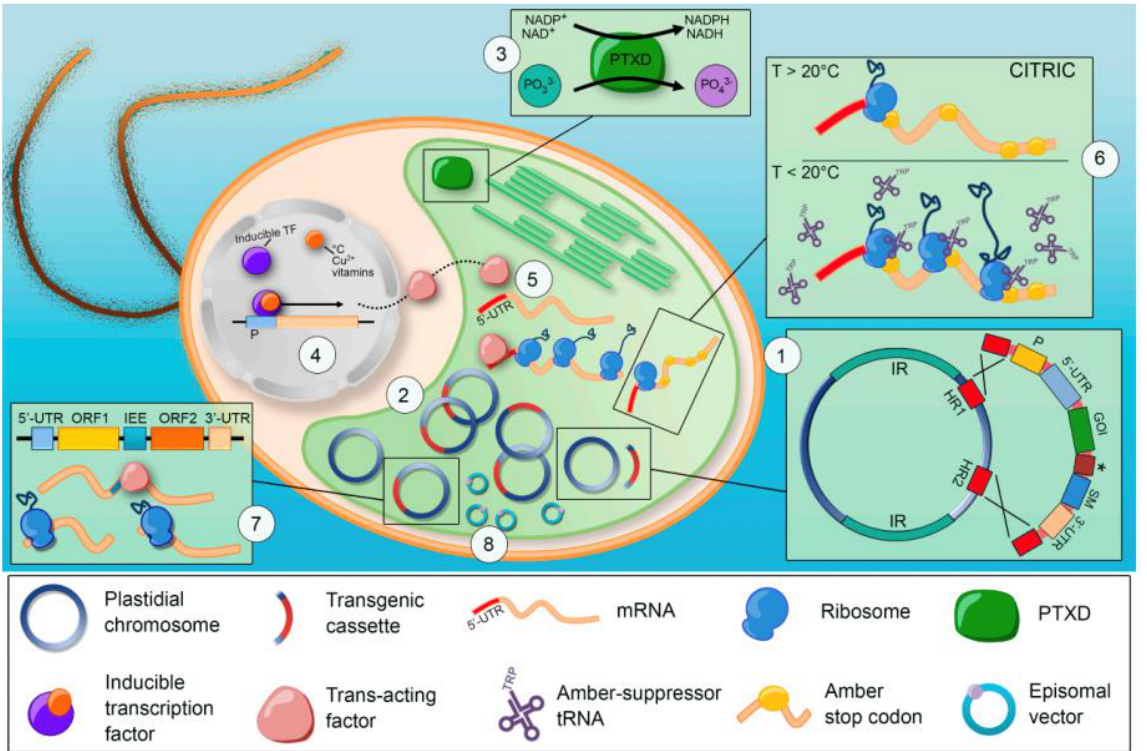
Figure 1. Chloroplast transformation in C. reinhardtii. Reprinted from ref. [103]. Almaraz-Delgado et al. performed the C. reinhardtii chloroplast modification utilizing